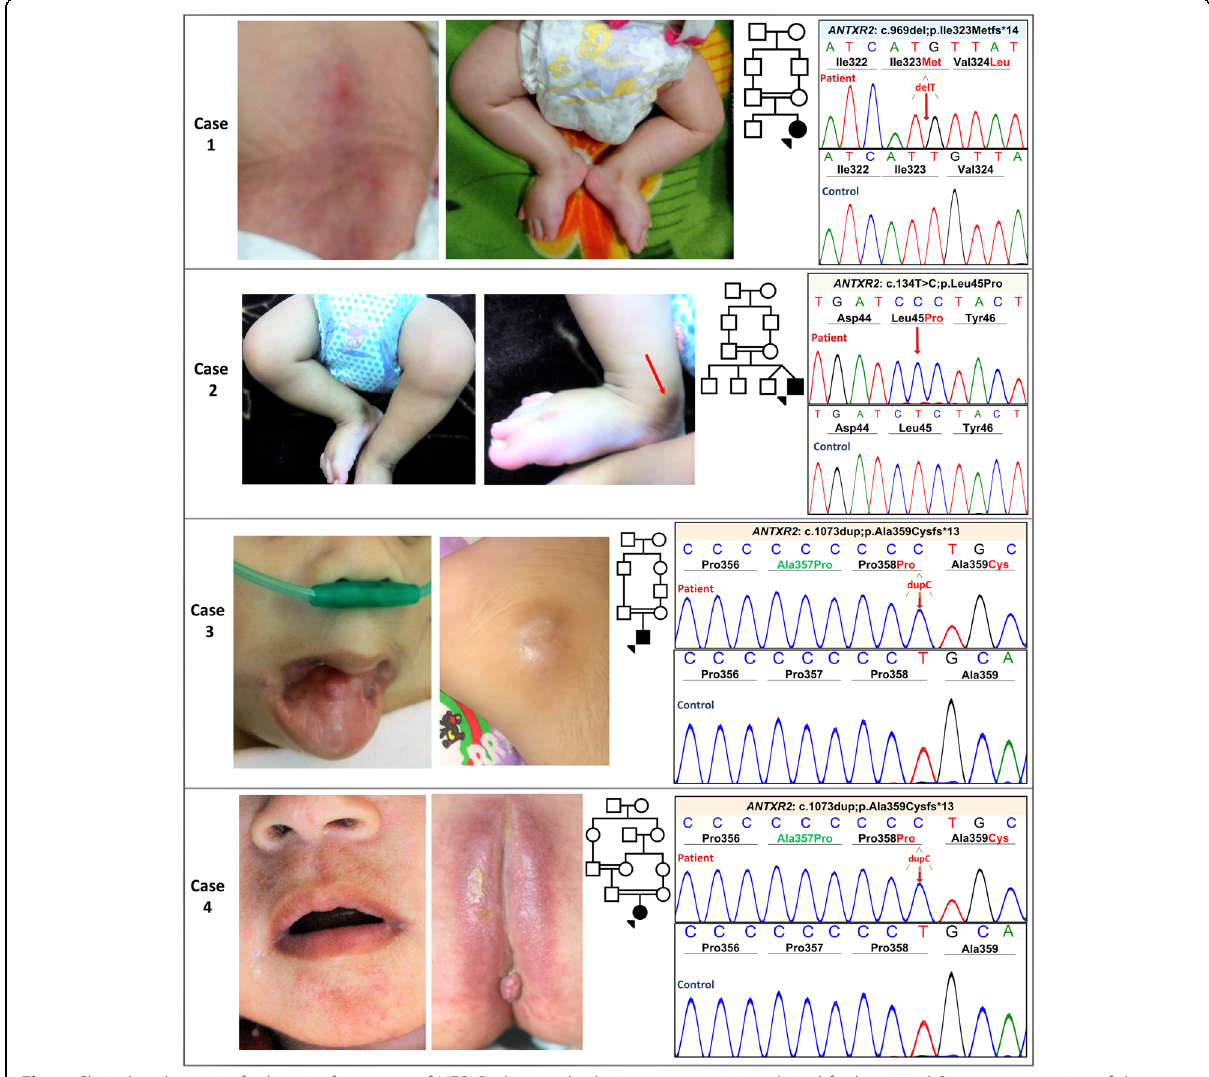
Fig. 1 Clinical and genetic findings in four cases of HFS. Pedigrees displaying consanguinity, clinical findings, and Sanger sequencing of the identified ANTXR2 mutations. In each case, the upper sequence panel represents the mutant allele, as compared to reference sequence in a healthy control below. a Clinical features of Case 1 included erythematous plaques, hyperpigmentation, and joint contractures of the lower extremities. Sanger sequencing identified a novel homozygous mutation, c.969del, which is predicted to result in truncated protein